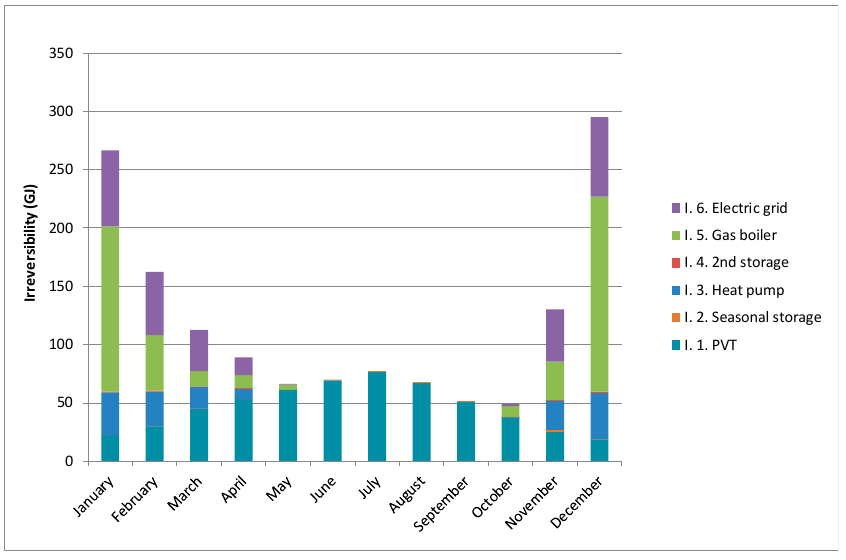
Figure 7. Complete system: Irreversibility.